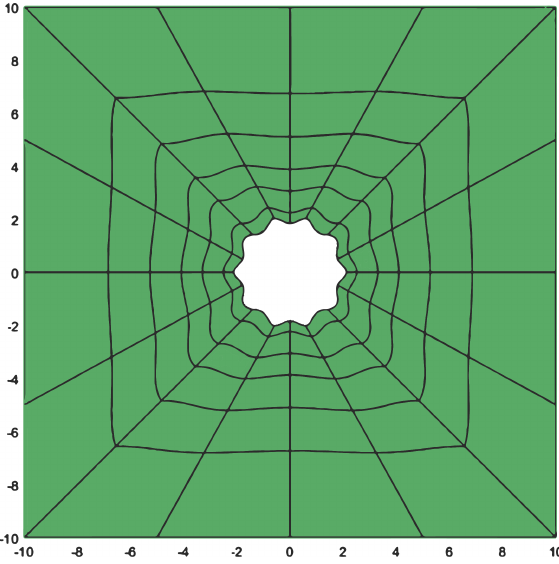
Figure 17. Case 3: physical domain and mesh with h 2